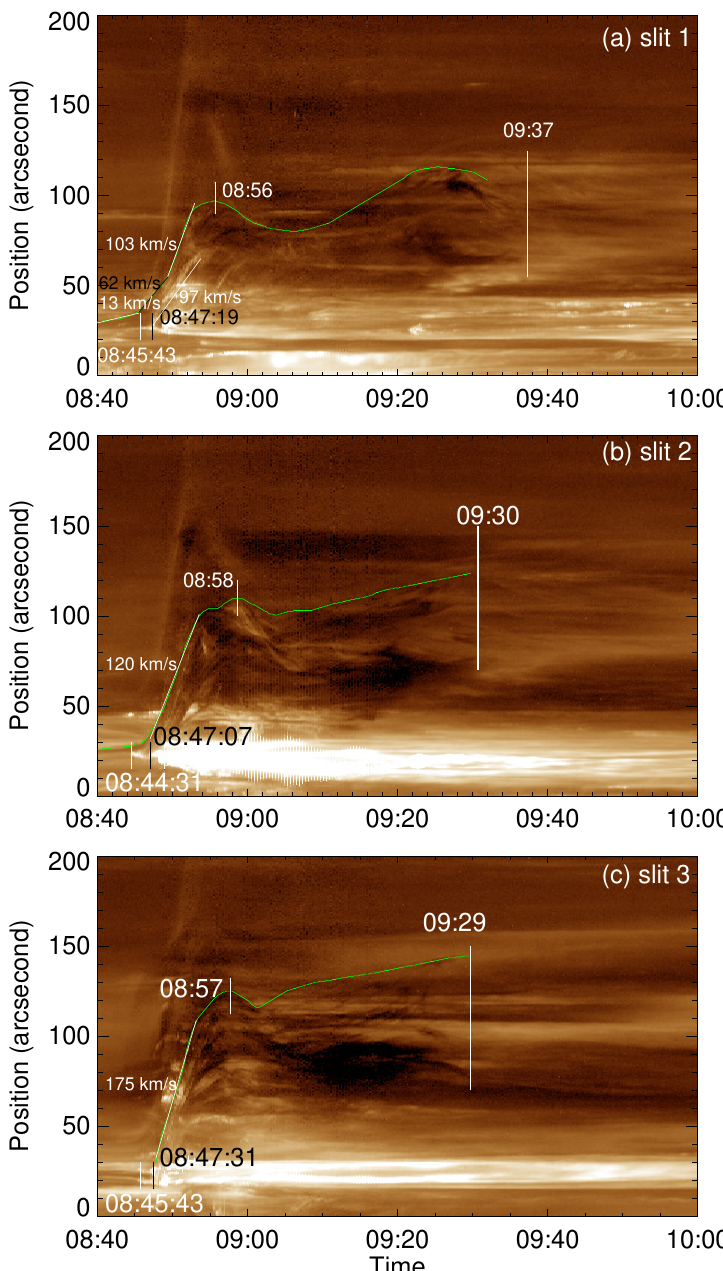
Figure 6. (Panel a – c ) are time-distance diagrams along the three slits as indicated in Figure 3. Green curves outline the profile of the upper limb of the erupted filament. Details can be found in